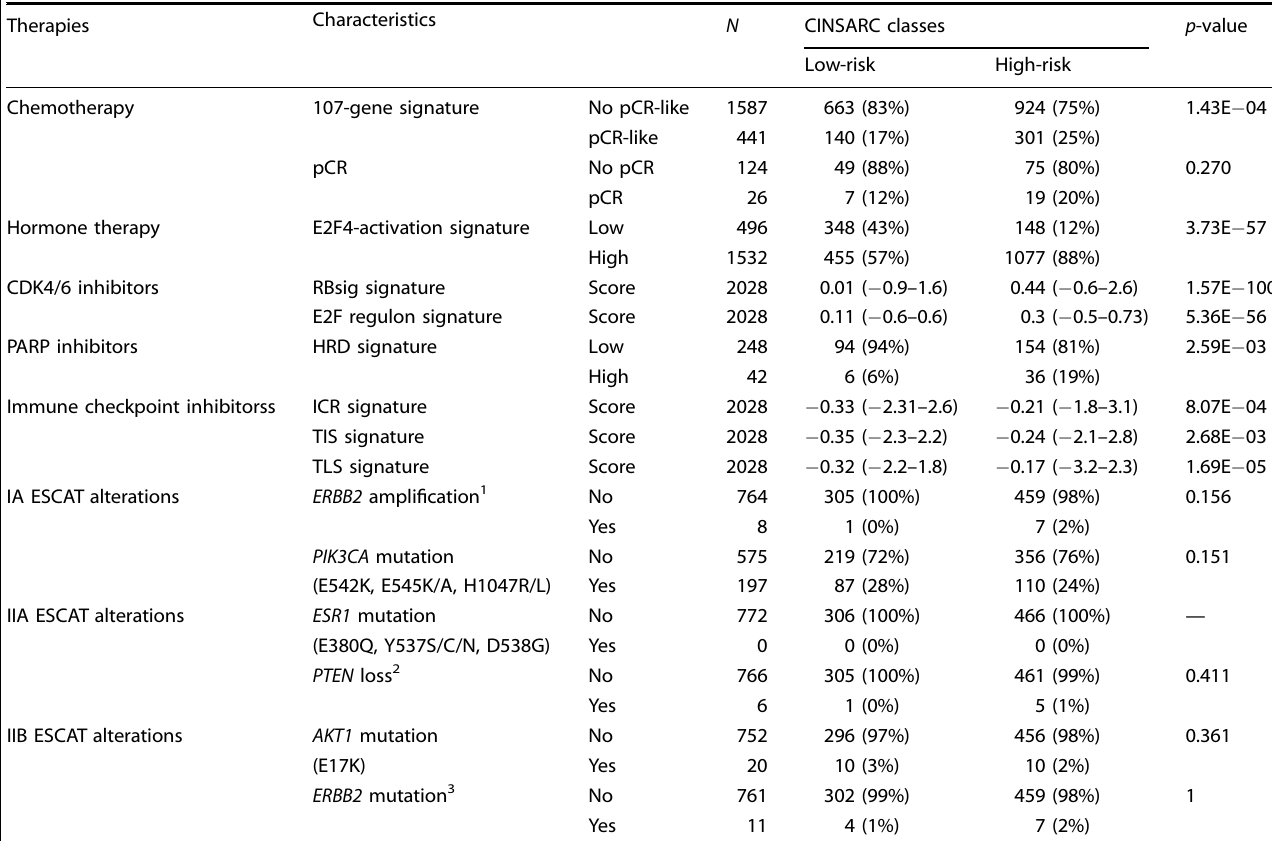
Table 5. Correlations of CINSARC classes with therapeutic response/vulnerability in Luminal B breast cancers. Therapies